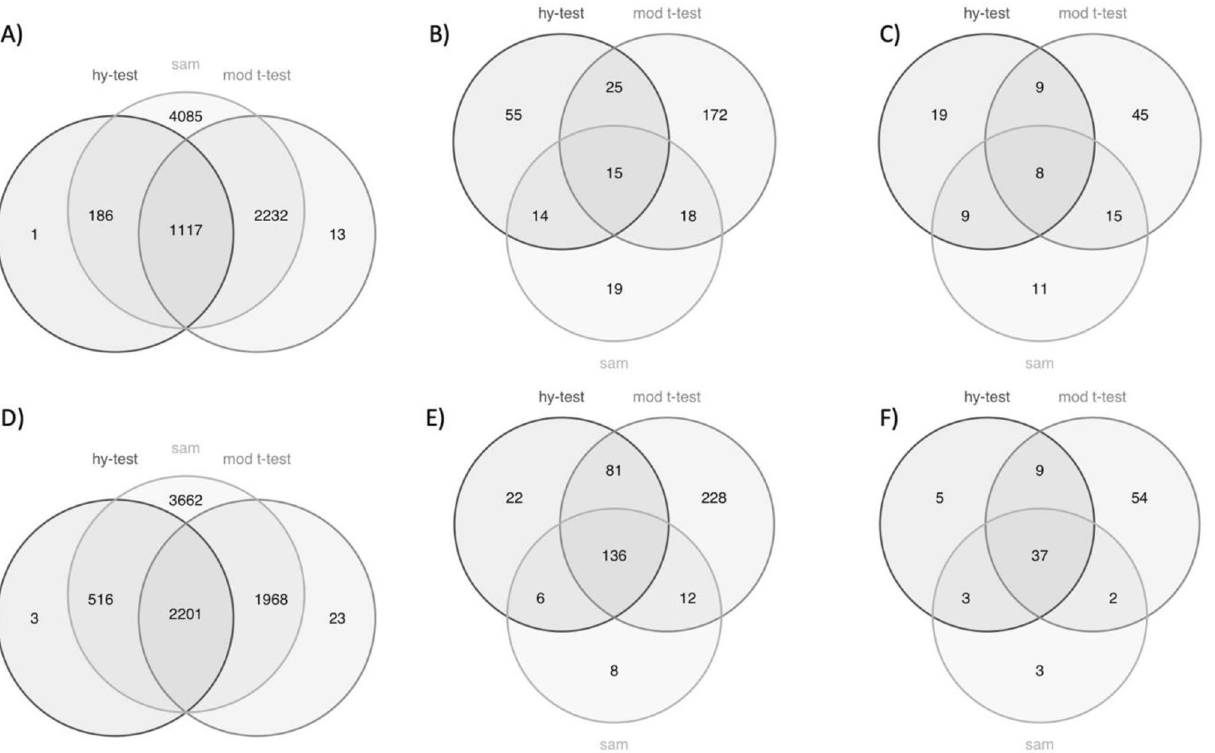
Figure 1. Venn diagrams of the differentially expressed genes and significant terms found in each of the three analysis steps by the three methods: Hy-test, moderated t-test, and SAM. The upper panels ( A , B , C ) refer to the breast tissue and the lower panels ( D , E , F ) to the kidney. The first column ( A and D ) refers to the DE analysis, the second column ( B and E ) to the enrichment analysis and the third column ( C and F ) to the PubMed research. Significance is assessed when a Bonferroni corrected p-value is below the 5%